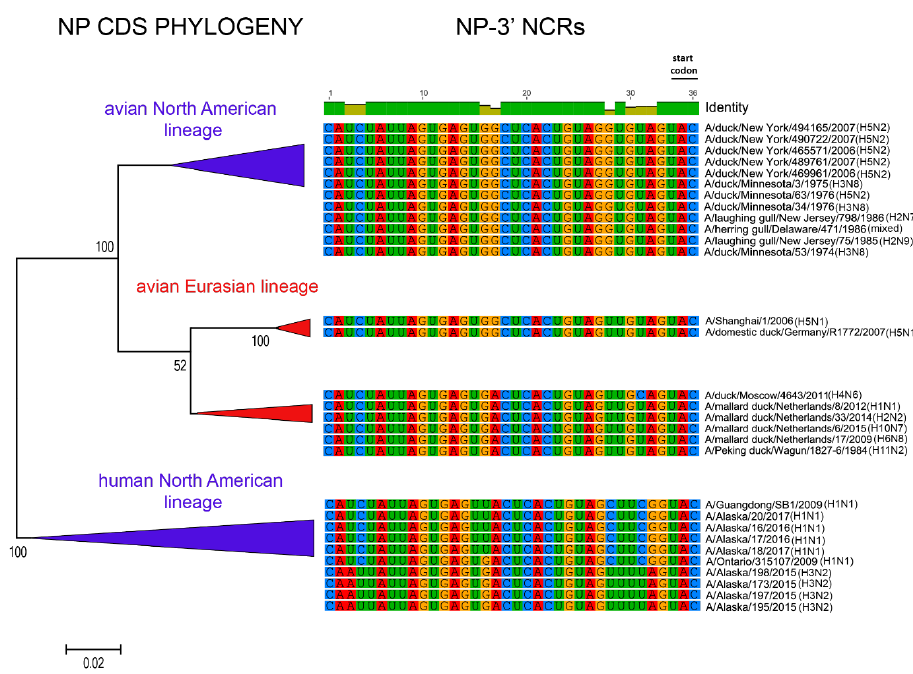
Figure 8. Relationships among NP 3 ′ NCR and CDS regions for viruses from different host species and geographic locations. Alignments of the 3 ′ NCRs, shown corresponding to the genomic RNAs, from the viruses used in the analyses are next to the CDS-based neighbor-joining tree for these viruses.